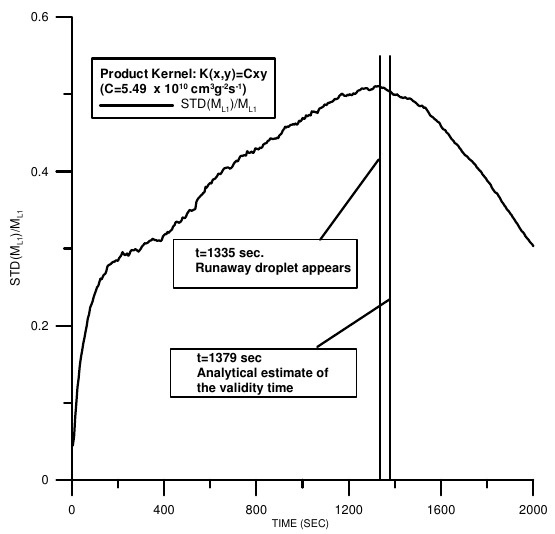
Figure 2. The ratio β (defined in Eq. 7) as a function of time, for the product kernel Fig. 2. The ratio (defined in Eq. 8) as a function of time, for K(x,y)=Cxy, ( C =5.49×10 10 cm 3 g -2 s -1 ). Note that STD(M L1 )/M L1 reaches a maximum the product kernel K(x,y)=Cxy ( C =5.49 × 10 10 cm 3 g − 2 s − 1 ). Note . when the runaway droplet appears. M L 1 reaches a maximum when the runaway that STD (M L 1 ) droplet